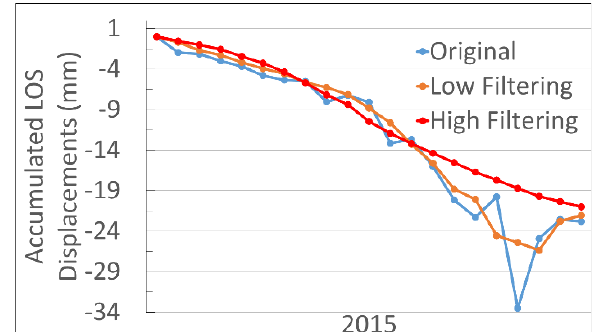
Figure 10. Time-series displacements of sinking point (Figure 7). Blue, original; Orange, low filtering; Red, high